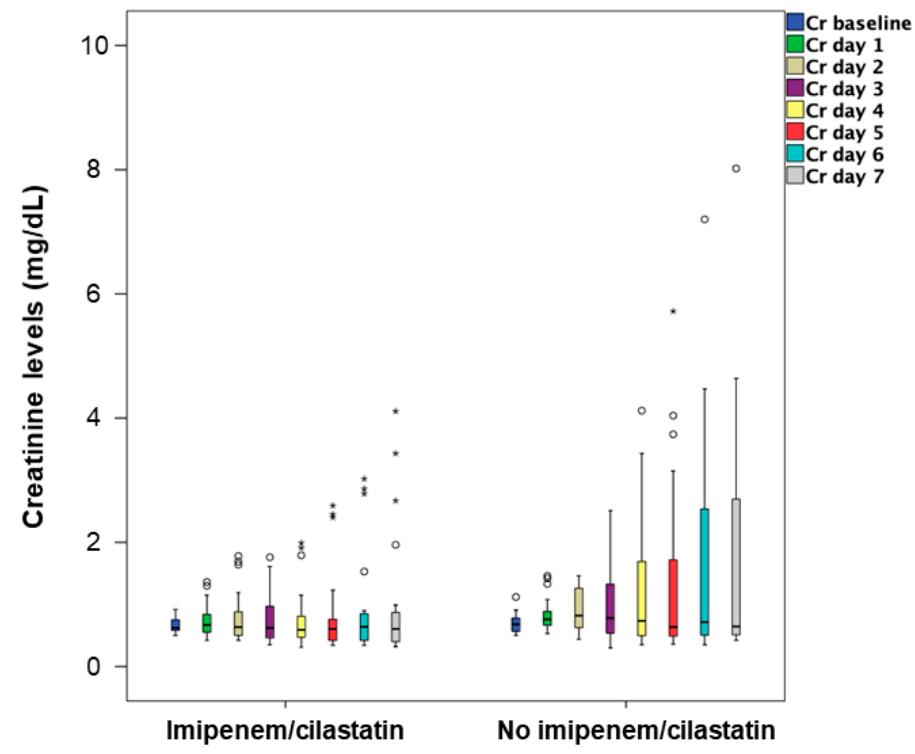
Figure 3. Boxplot of serum creatinine from baseline and up to day 7 in both groups. Boxes show the median and the interquartile range. Whiskers show upper and lower adjacent values.